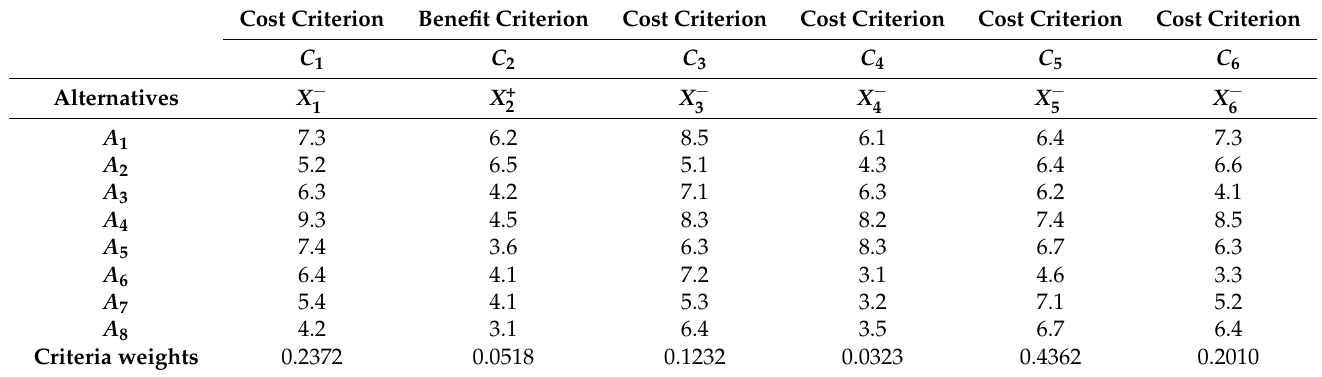
Table 7. Initial decision matrix for ranking natural hazards in